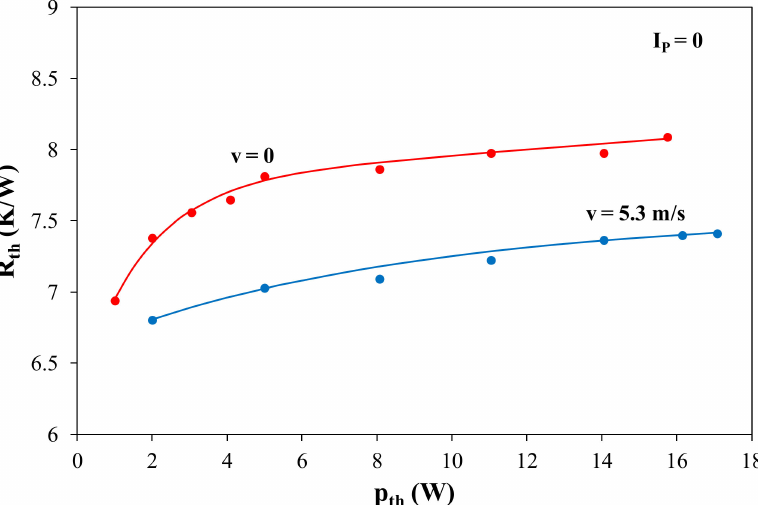
Figure 14. Measured and modelled dependences of the thermal resistance of the resistor mounted on the heat sink with two thermal pads and the Peltier module on the dissipated power at selected values of the airflow speed (system